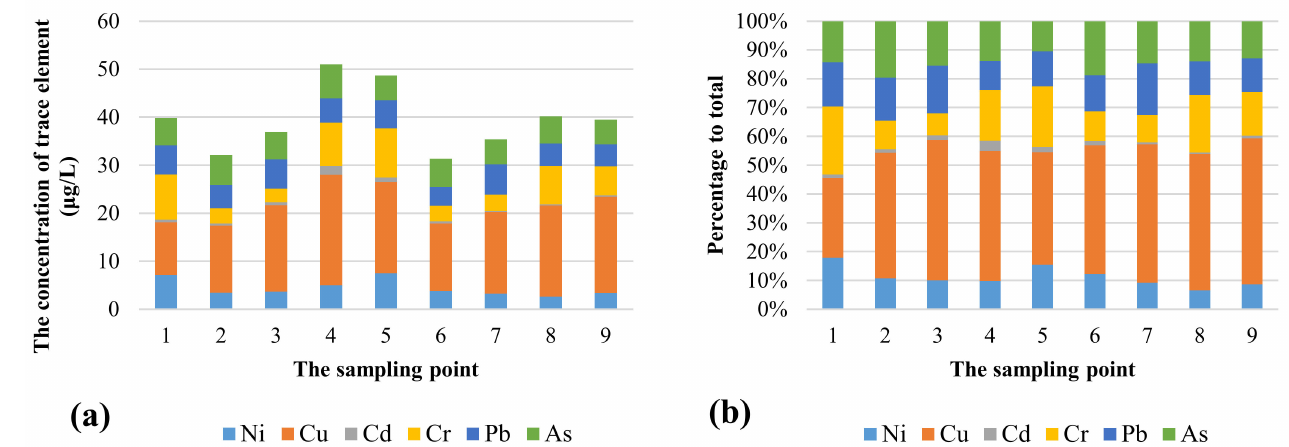
Figure 5. ( a ) Total concentrations of the trace elements at the sampling points ( µ g/L); ( b ) percentage of various trace elements out of the total concentrations at each sampling point.